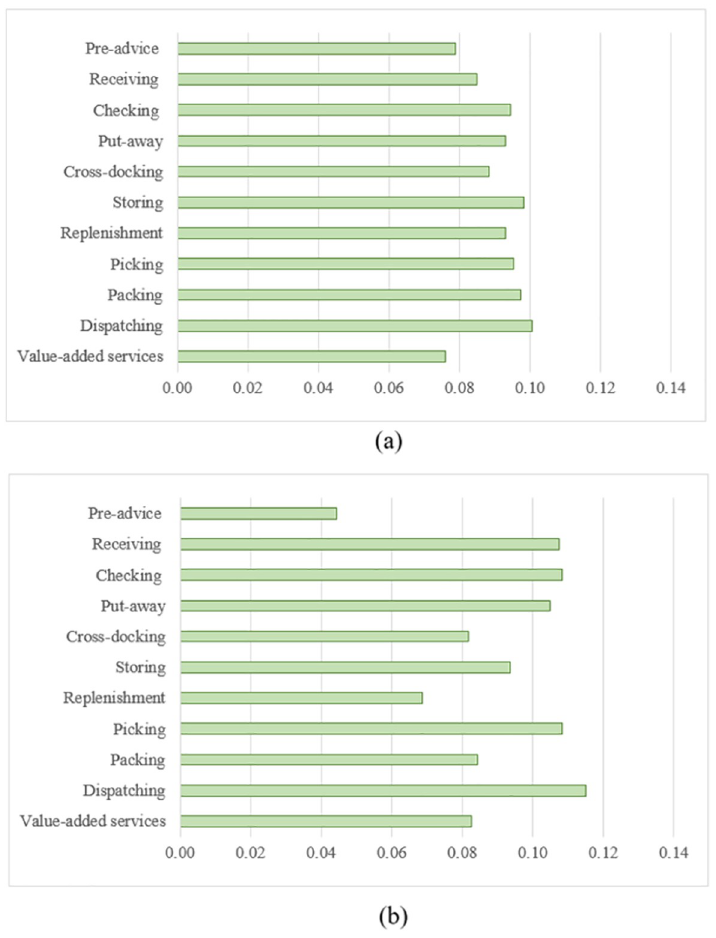
Fig 5. The relative weights of the processes, as sub-criteria, for two product classes. (a) Class 5: Pharmaceuticals, medical and veterinary preparations; etc. and (b) Class 25: Paper and cardboard; etc. https://doi.org/10.1371/journal.pone.0256999.g005 5.1.7 Initializing a population. A population that consisted of 300 sets of parameters for the three clusters mentioned previously was randomly initialized. Such parameters were then coded as strings. In this research work, six-bit binary strings were used to define these parame- ters. Such strings were then concatenated and mapped to decimal values.